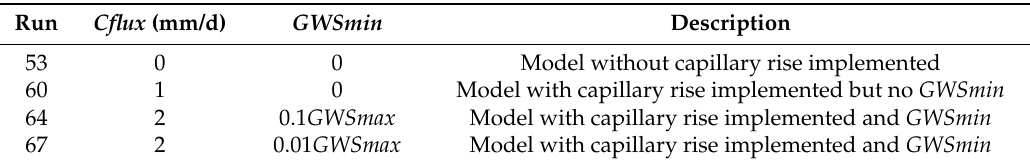
Table 4. Characteristics of model runs presented in the results section.